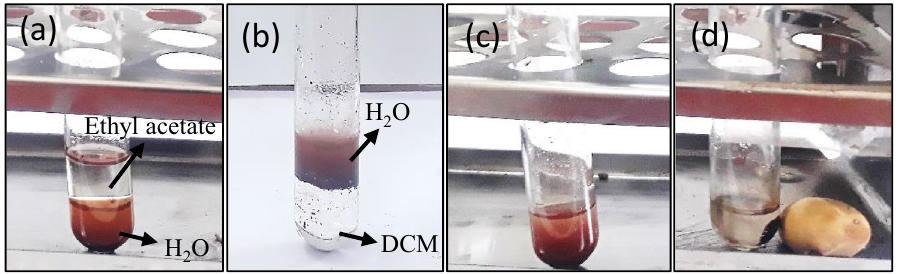
Figure 13. ( a ) Distribution of γ-Fe 2 O 3 @PEG@PAMAM G 0 -Cu in biphasic H 2 O-ethyl acetate, ( b ) distribution of γ-Fe 2 O 3 @PEG@PAMAM G 0 -Cu in biphasic H 2 O-dichloromethane (DCM), ( c ) dispersion of γ-Fe 2 O 3 @PEG@ PAMAM